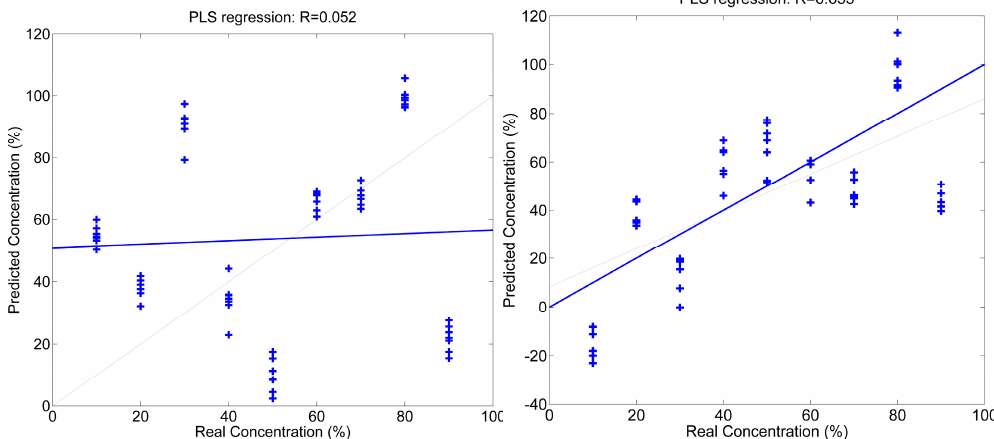
Figure 3. PLS predictions of the different wine concentrations, left figure for the white wine samples and right figure for the red wine samples.